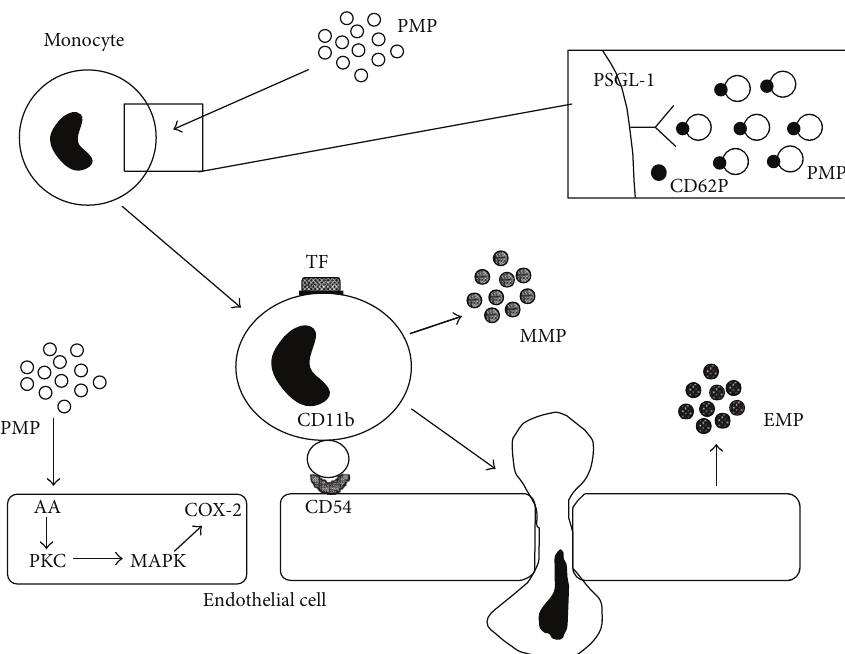
Figure 2: Mechanism of vascular changes by platelet-derived microparticles (PMPs). PMPs activate monocytes by a reaction between P- selectin and PSGL-1 (P-selectin glycoprotein ligand-1). Activated monocytes induce expression on the cell surface of tissue factor (TF) and CD11b.Activatedmonocytesalsoinducereleaseofmonocyte-derivedmicroparticles(MMPs).PMPsinduceCOX-2productioninendothelial cells. PMPs enhance expression of CD54 (ICAM-1) on the endothelial surface. Activated endothelial cells also induce release of endothelial cell-derived microparticles (EMPs), enhancing adhesion between endothelial cells and monocytes. Finally, monocytes induce migration of endothelial cells, resulting in vascular changes. Abbreviations: arachidonic acid (AA); protein kinase C (PKC); mitogen-activated protein kinase (MAPK) (adapted from Nomura, 2001